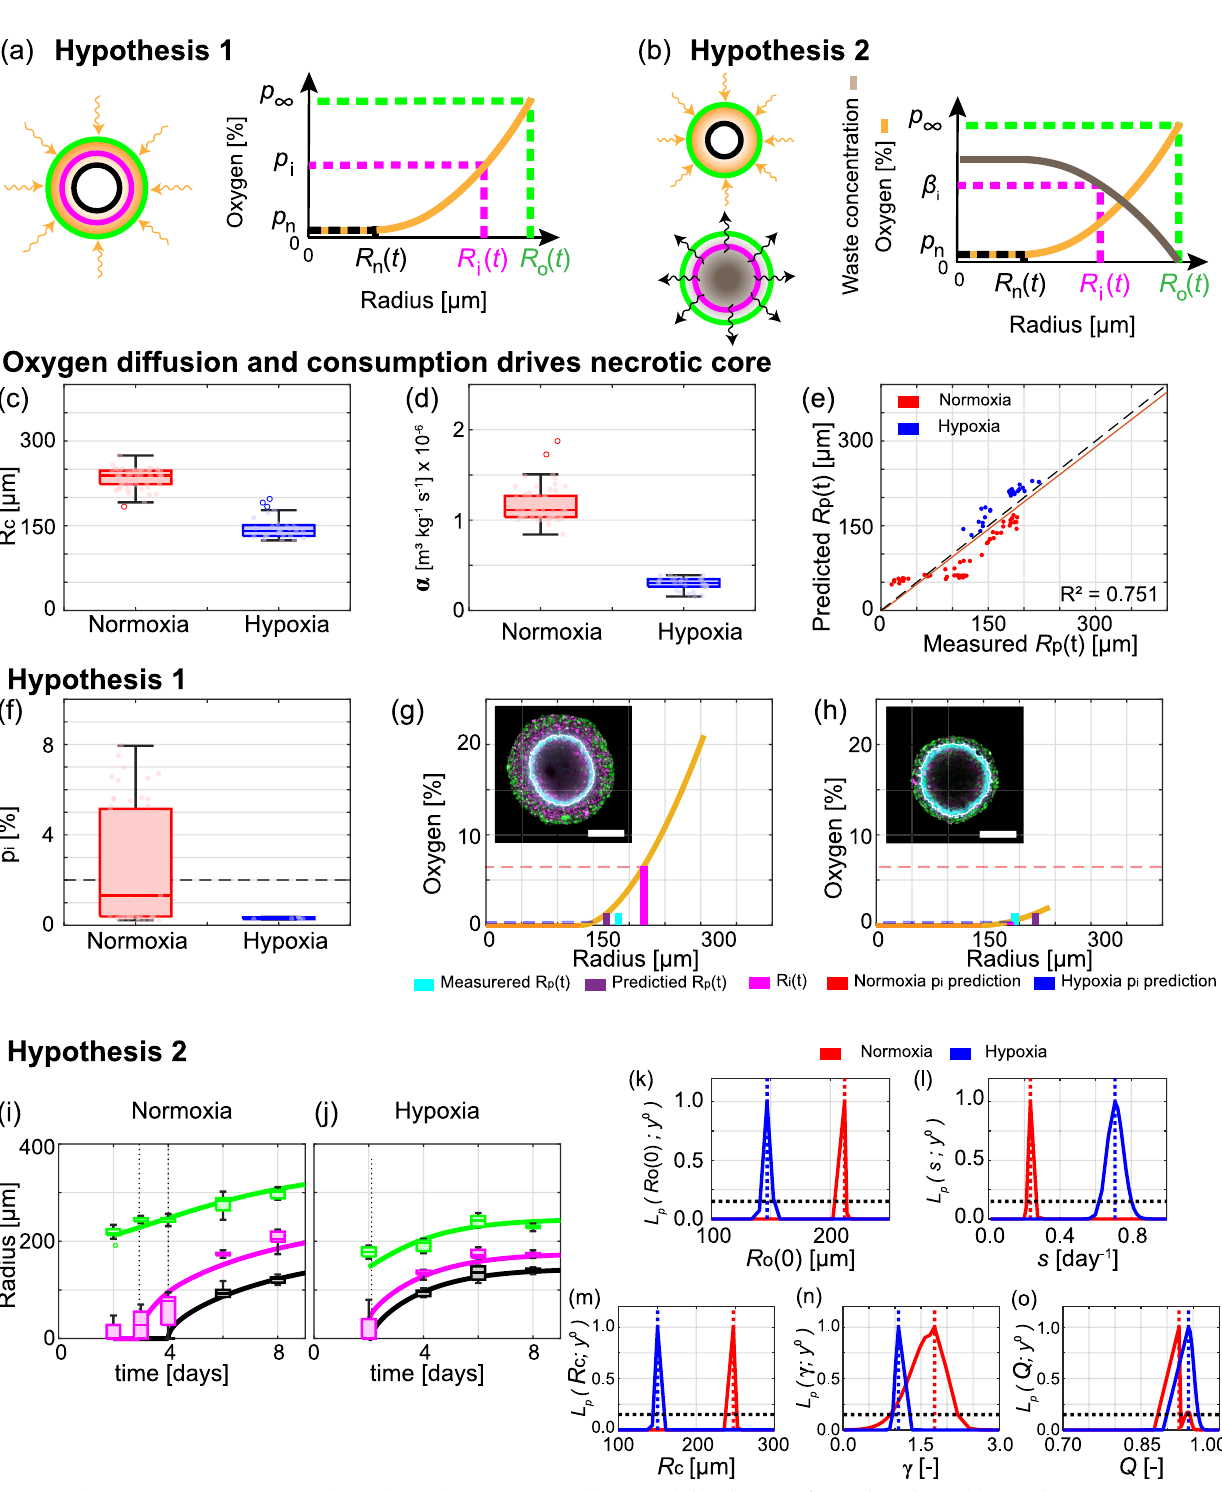
Fig 3. Mechanisms governing tumour spheroid growth in normoxia and hypoxia. (a,b) Schematics for two hypotheses. (a) Hypothesis 1: oxygen diffusion and consumption drives formation and growth of necrotic and inhibited regions. R n ( t ) [ μ m] and R i ( t ) [ μ m] implicitly defined via oxygen partial pressure thresholds p n [%] and p i [%], respectively. (b) Hypothesis 2: oxygen diffusion and consumption drives formation and growth of necrotic region, waste production and diffusion drives formation and growth of inhibited region. R n ( t ) [ μ m] implicitly defined via oxygen partial pressure thresholds p n [%]. R i ( t ) [ μ m] implicitly defined via waste threshold β i [mol μ m − 3 ]. (c-h) Analysis of spheroid snapshots assuming hypothesis 1. Box charts representing